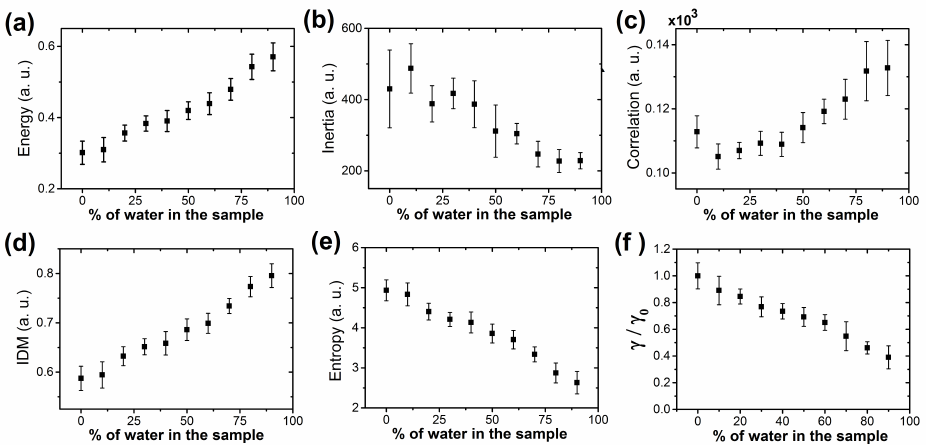
Figure 3. Texture analysis of dried droplets of Methotrexate/NaCl. The GLCM parameters (( a ) Energy, ( b ) Inertia, ( c ) Correlation, ( d ) IDM and ( e ) Entropy) of Methotrexate/NaCl patterns produced with varying ratios of tap water at T s = 63 ◦ C and RH = 25%. ( f ) The normalized crown thickness γ / γ 0 of patterns in dried droplets of Methotrexate/NaCl as a function of ratios of tap water at T s = 63 ◦ C and RH = 25%. Here, γ 0 is the crown thickness of Methotrexate/NaCl pattern formed without the addition of any agent. The error bars are standard deviations for n =